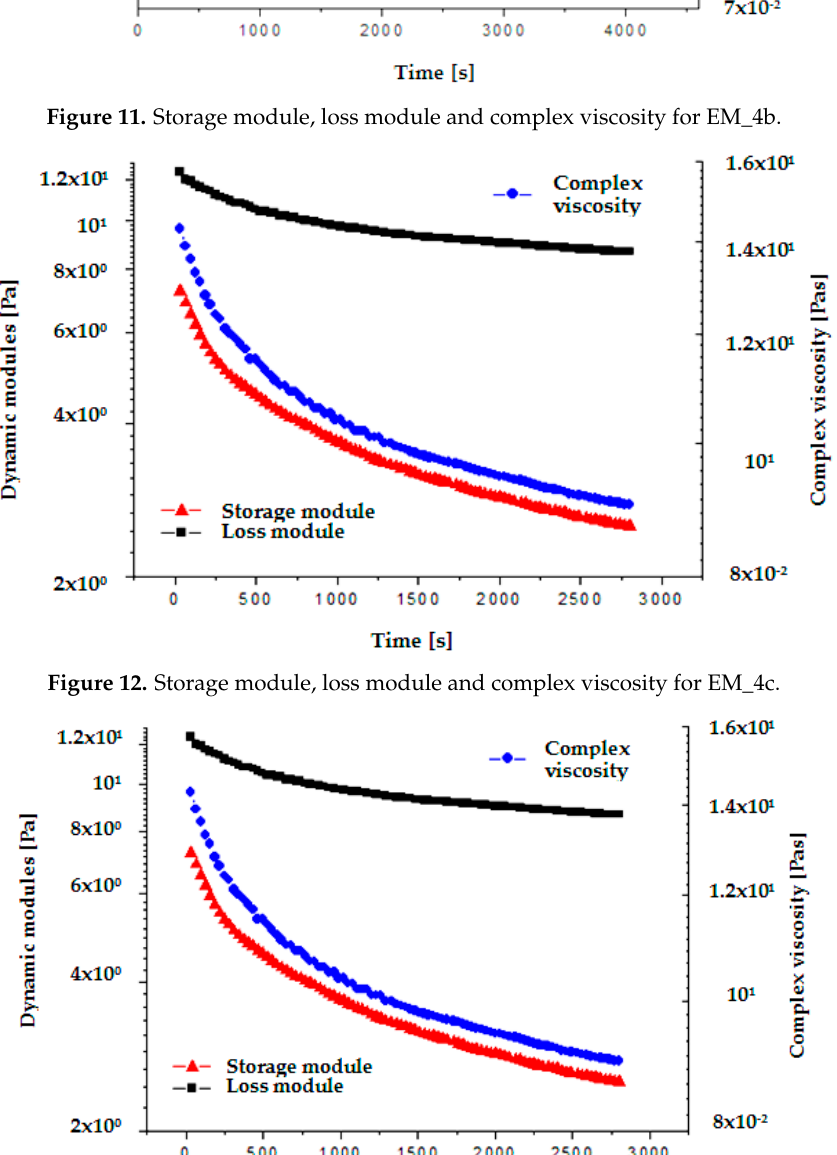
Figure 13. Storage module, loss module and complex viscosity for EM_4c, after a 2 min relaxation.